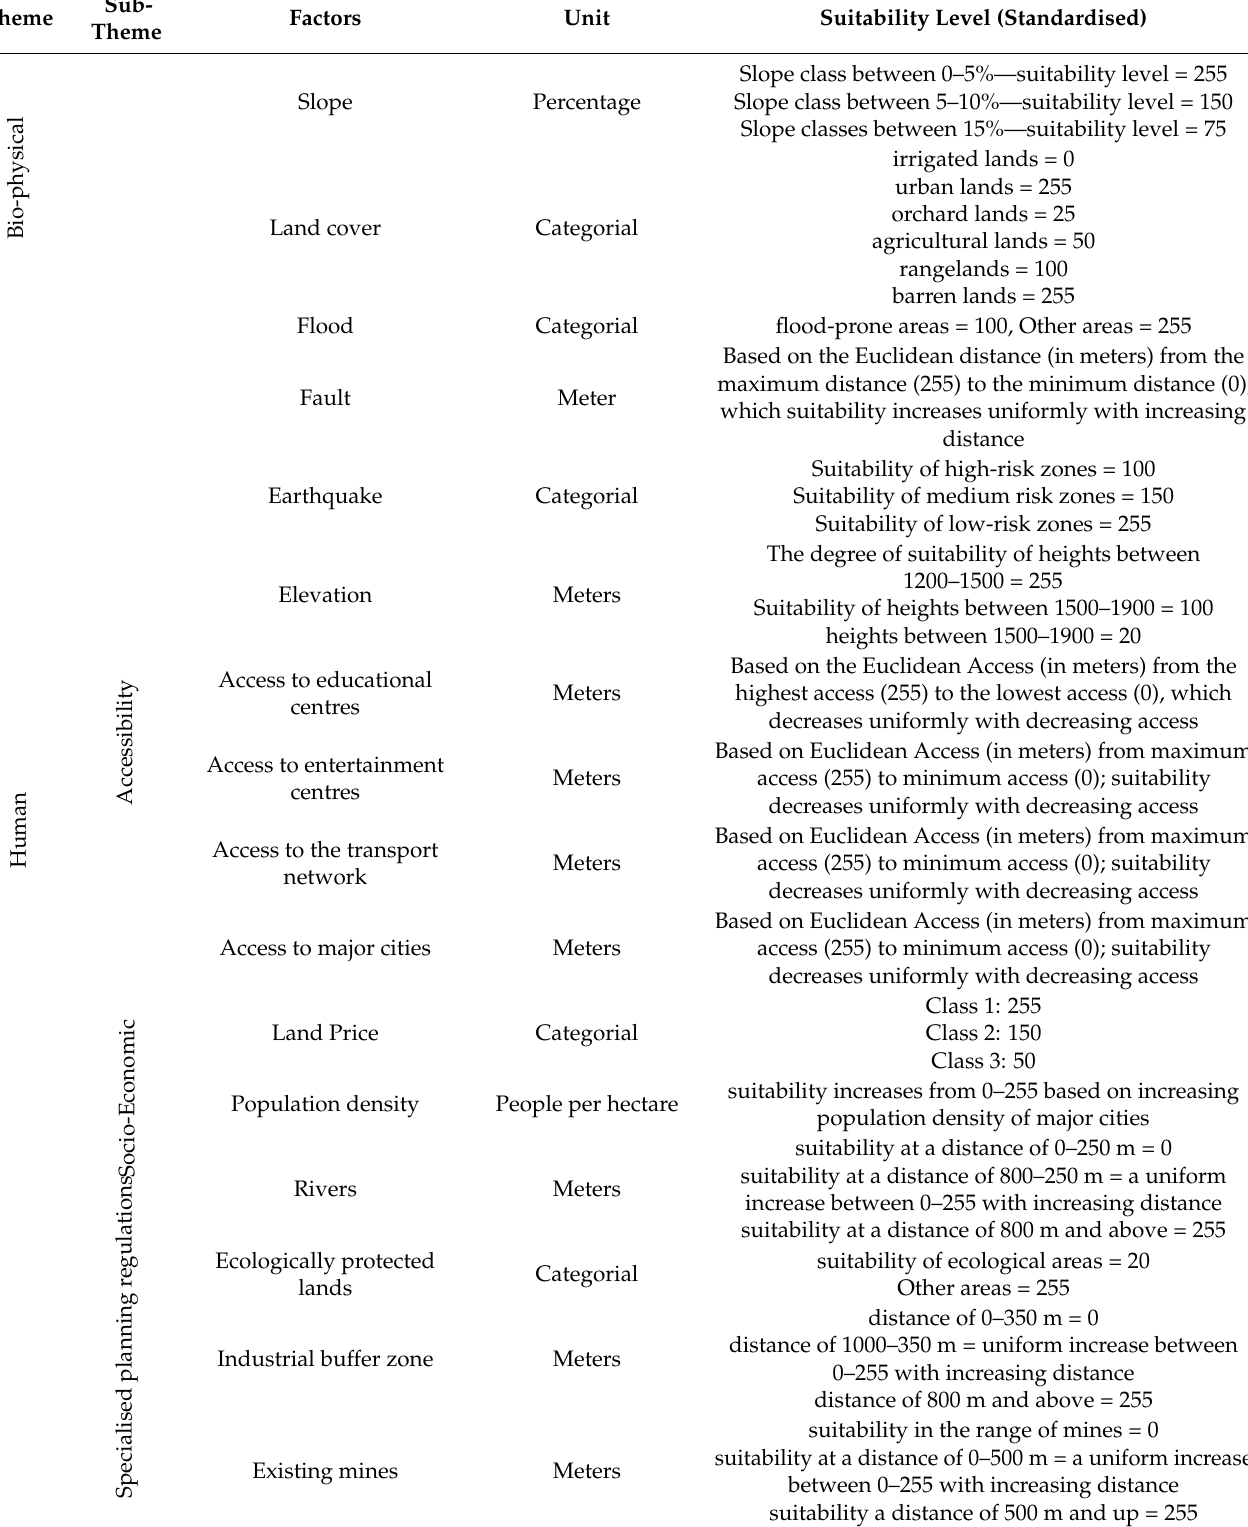
Table 3. The selected driving forces and their